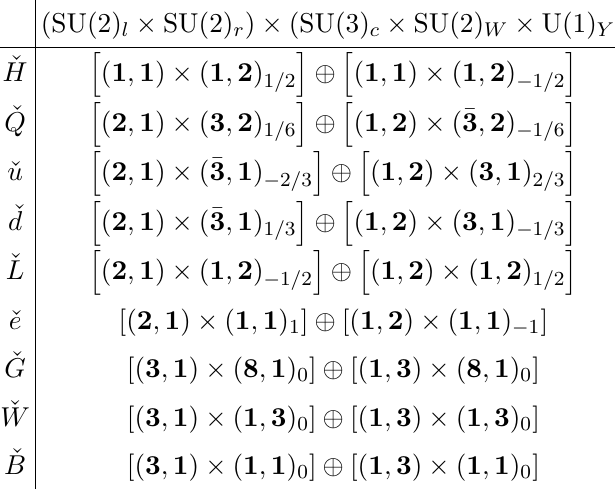
Table 1 . The spurions for our Hilbert series method and their representations under Lorentz and gauge